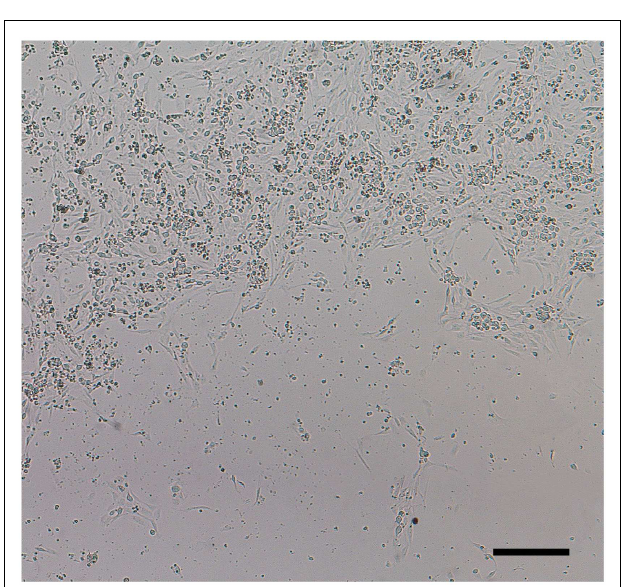
FIGURE 5 | “Edge-effect.” DRG neurons cultured in 24-well Seahorse XF24 microplates at RT display uneven distribution when placed directly in a humidified incubator at 37˚C and 5% CO 2 .This “edge-effect” is caused by a thermal gradient between the periphery and center of each well. DRG neuronal culture at 1 DIC seeded at 50,000 cells/well of an XF24 polystyrene microplate at 5 × phase objective. Scale bar: 200 µ